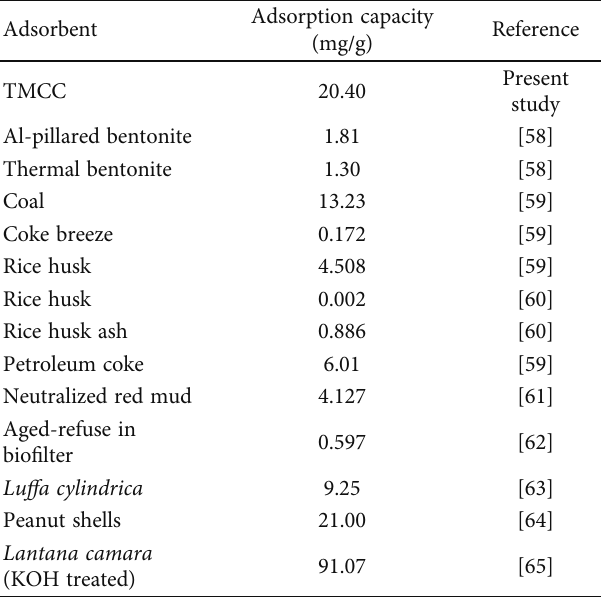
Table 4: Comparison of adsorption capacities of various bioadsorbents for phenol removal from aqueous